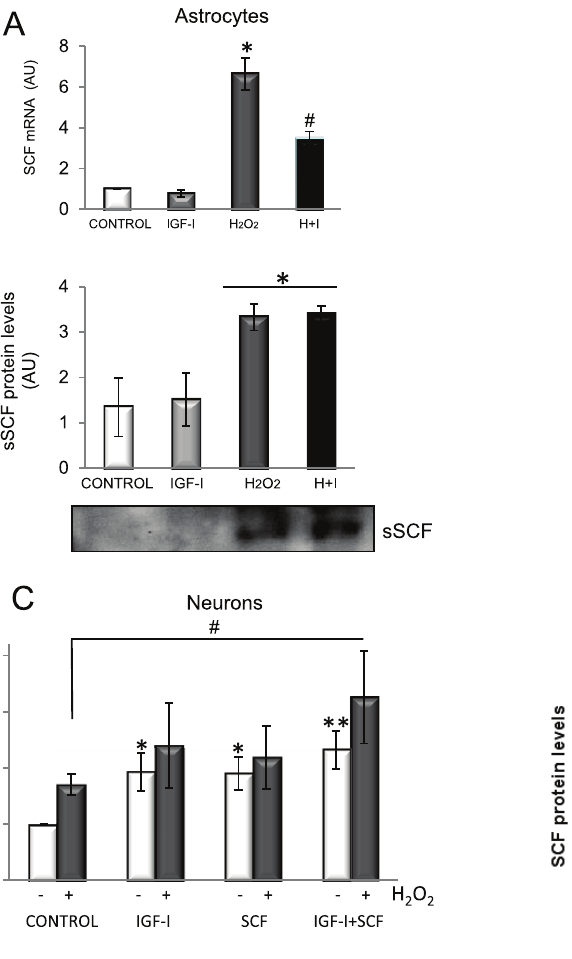
O stimulates SCF mRNA levels in astrocytes 2 2 O ). 2 2 O and/or IGF-I 2 2